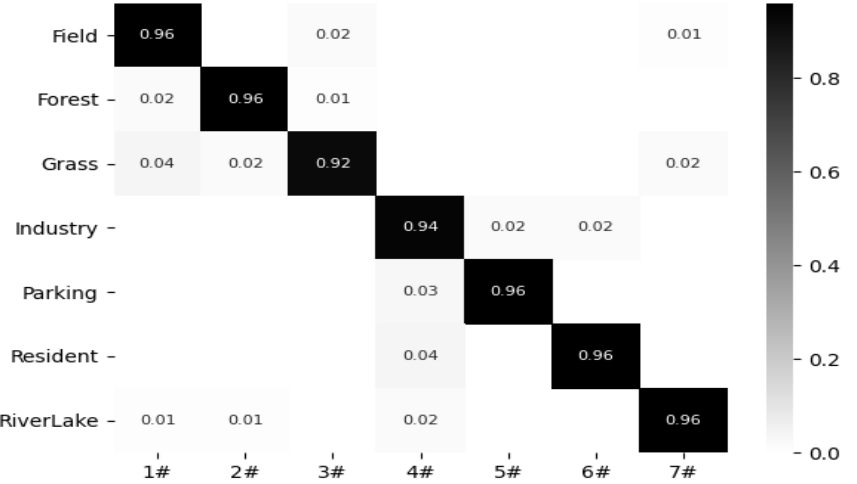
Figure 11. Confusion matrix of the proposed method on the RSSCN7 dataset.